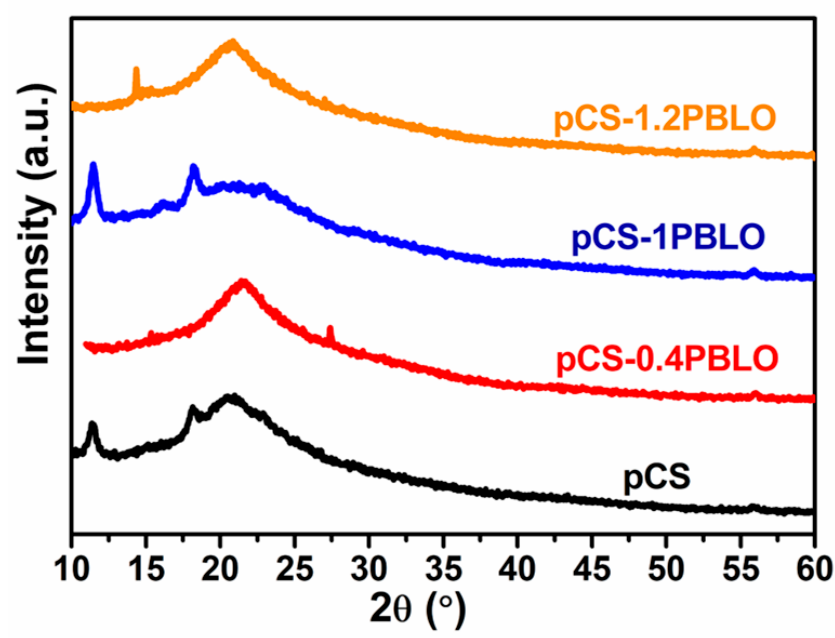
Figure 2. XRD analyses of pCS, pCS ‐ 0.4PBLO, pCS ‐ 1PBLO, and pCS ‐ 1.2PBLO.